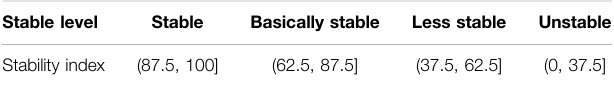
TABLE 5 | Evaluation standard for swamp wetland.